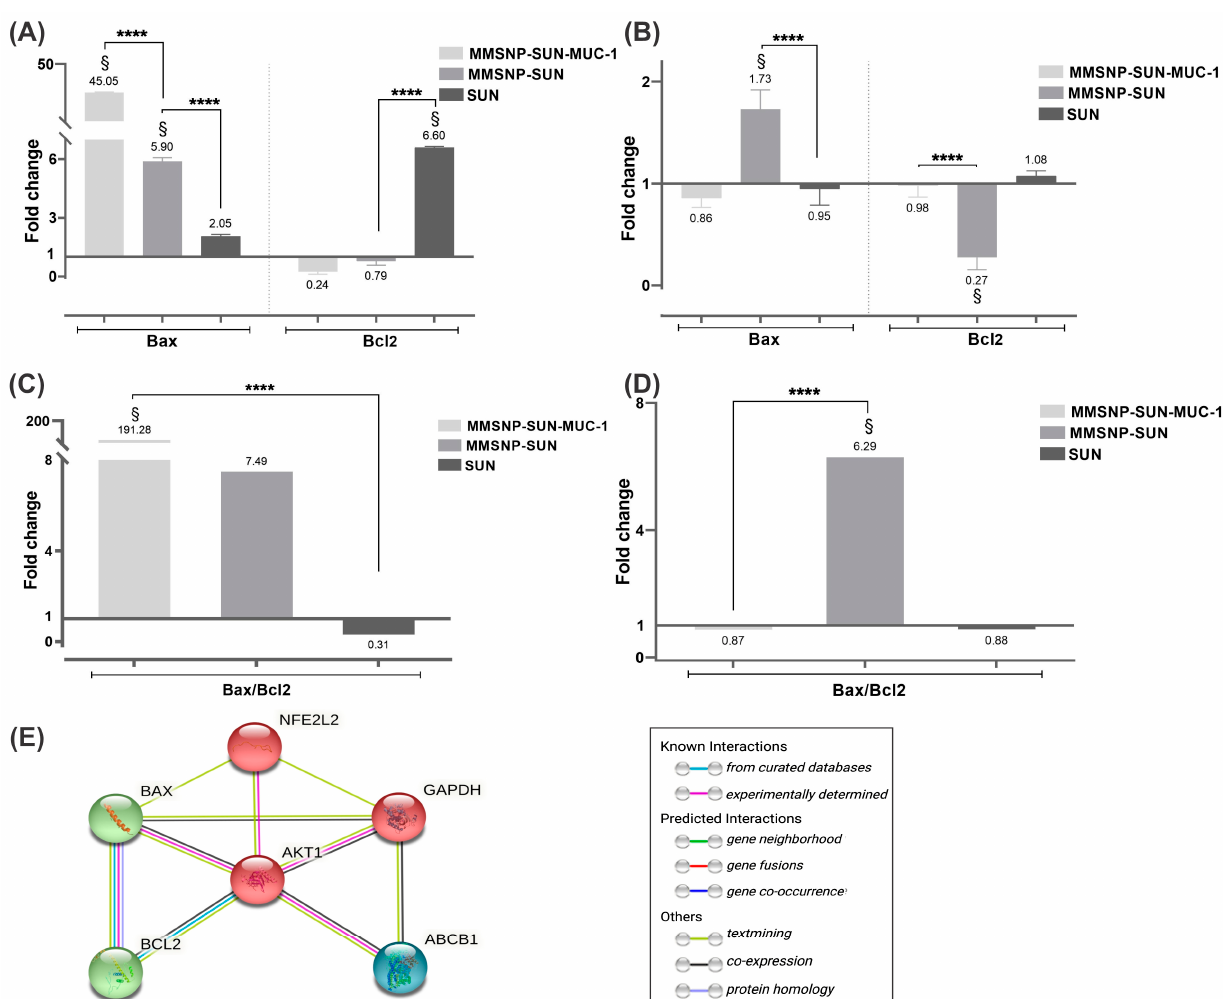
Figure 5. The gene expression analysis by real-time PCR; Bax and Bcl2 ( A , B ) and the ratio of Bax/Bcl2 ( C , D ), respectively in OVCAR-3 cells and MDA-MB-231 cells. The protein–protein interactions (PPI) of apoptosis-related proteins and antioxidant enzymes analysis using STRING v. 10.5 software with a medium confidence score of 0.400 and Kmeans clustering algorithm with 3 clusters ( E ). §: Statistical significance ( p < 0.05) compared with untreated control (Y = 0). The asterisks represent the following level of significance; not significant **** p ≤ 0.0001.